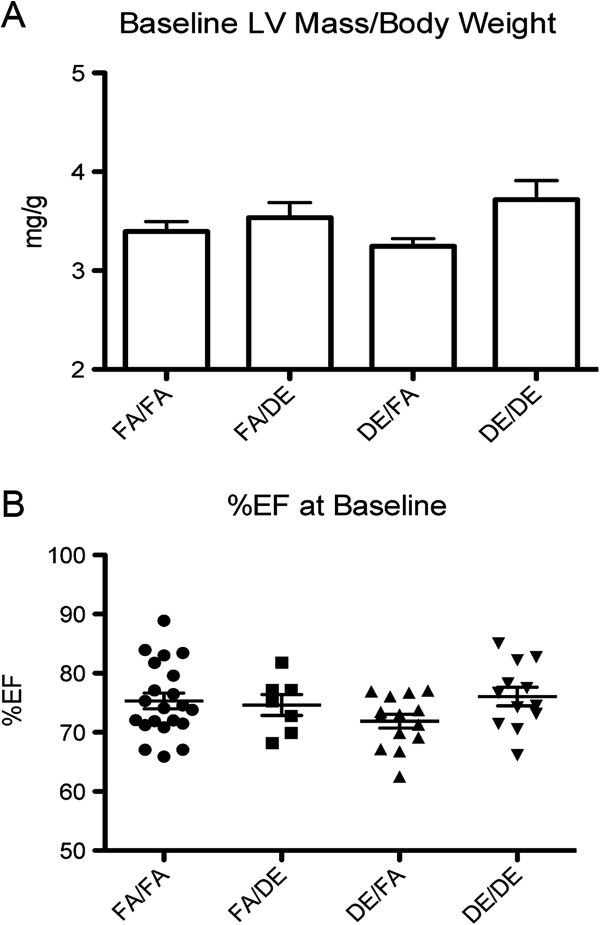
Echocardiographic assessment of cardiac hypertrophy and function at 12 week of age, prior to TAC/Sham surgeries. (A) Calculated LV Mass normalized to body weight and (B) percentage ejection fraction (%EF) in FA/FA (n = 21), FA/DE (n = 7), DE/FA (n = 14), and DE/DE (n = 12) groups.